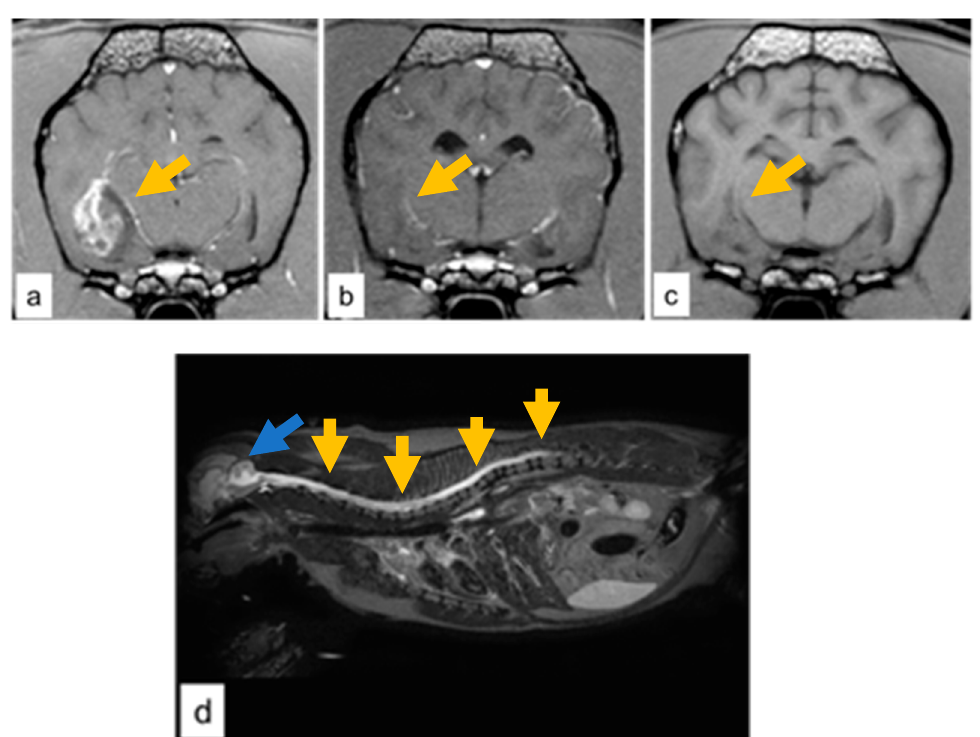
Figure 1. Case 3, grade IV glioma ( a ) T1-W image with contrast enhancement showing a well-demarcated tumor at the temporal-paraventricular region (dark-yellow arrow). ( b ) Two months post RT near-complete regression was observed (dark-yellow arrow). ( c ) Six months post RT, hypointense lesion consistent with a gliotic scar at the temporal-paraventricular region (dark-yellow arrow). ( d ) Case 4, grade IV glioma; cervical and thoracic involvement of the spinal cord on T2-W image by the hyperintensity signal (dark-yellow arrow). and with concomitant enlargement of the fourth ventricle (blue arrow).